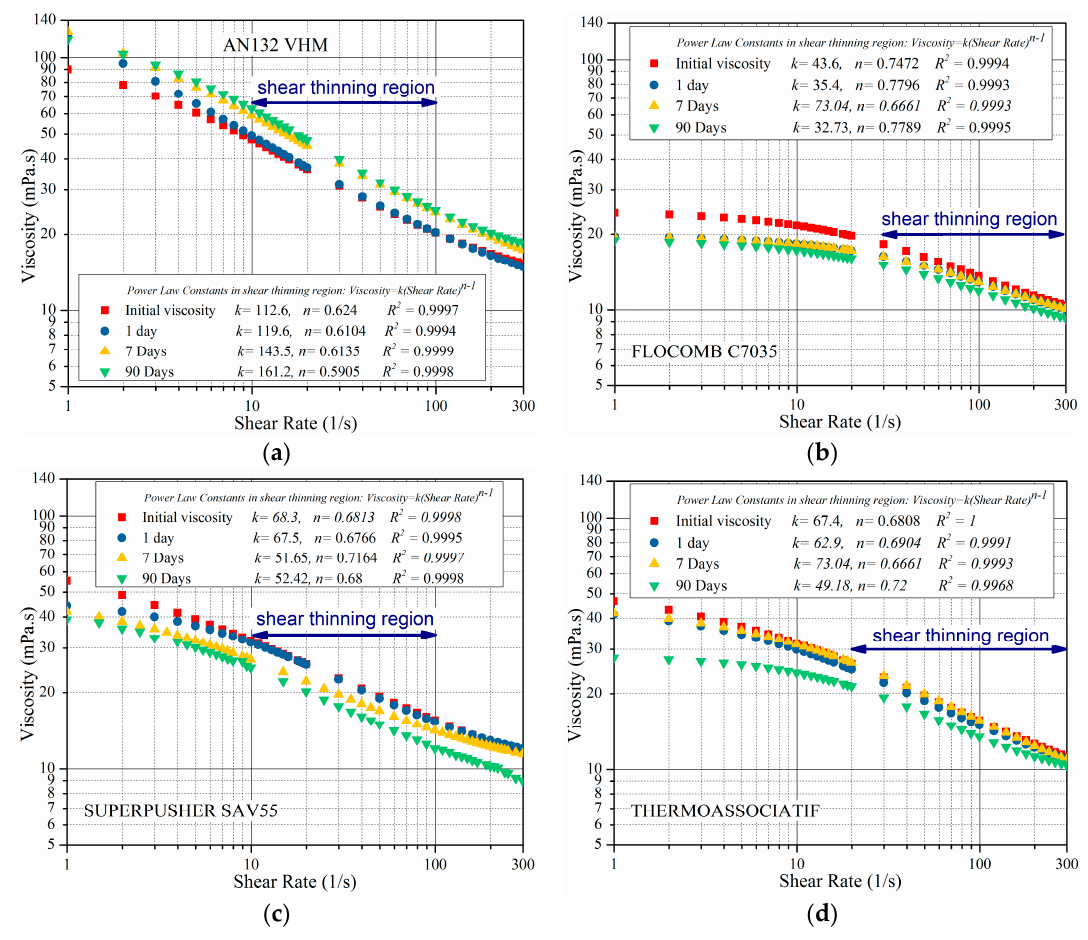
Figure 10. The viscosity as a function of shear rate for polymers aged up to 90 days at 80 °C, and in CaCl 2 -NaCl including 3 wt % IBA.